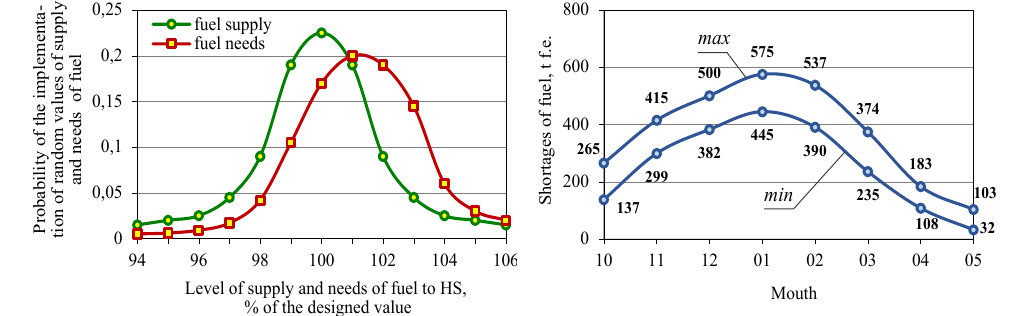
Fig. 6. Range of calculated possible shortages of fuel on